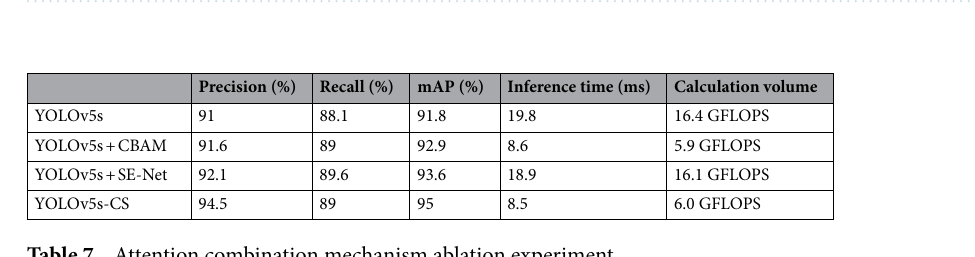
Table 7. Attention combination mechanism ablation